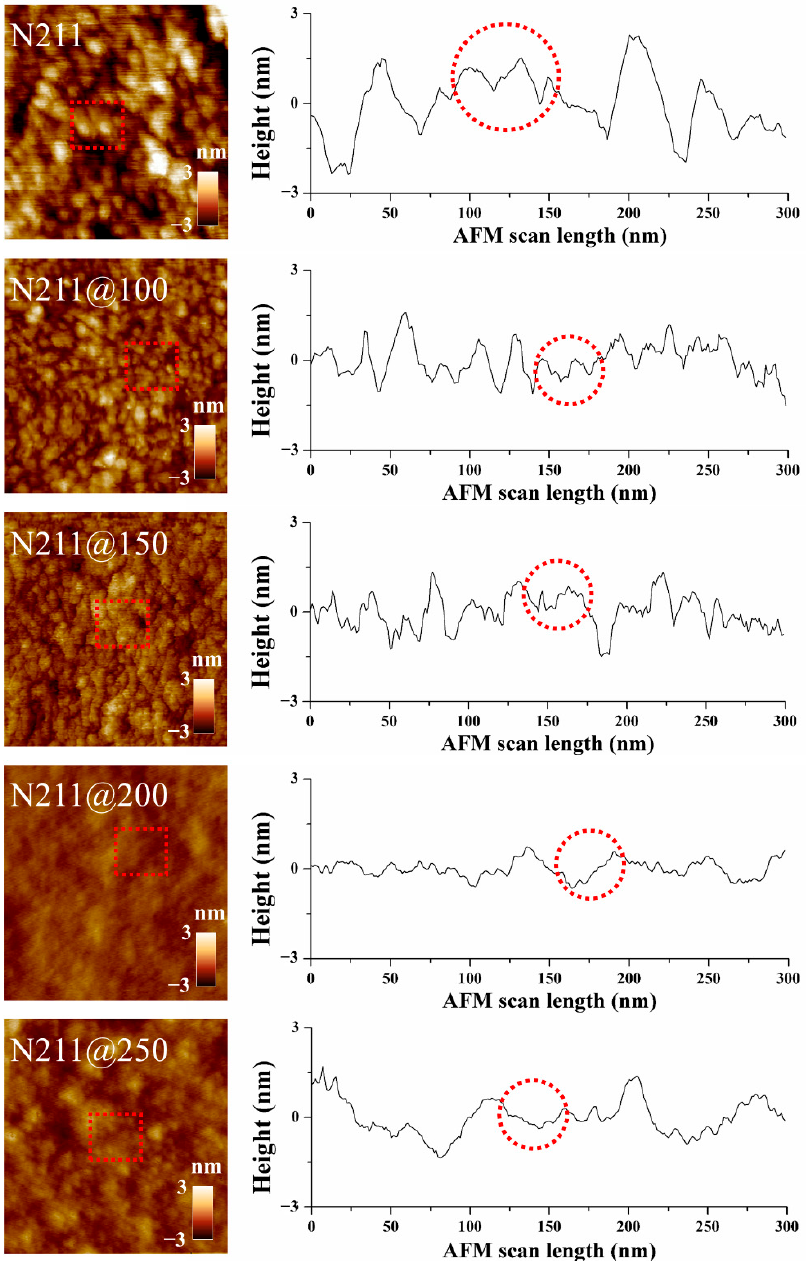
Figure 3. AFM topography measured in tapping mode of pristine and annealed membranes ( left ), and corresponding cross-sectional topography ( right ).